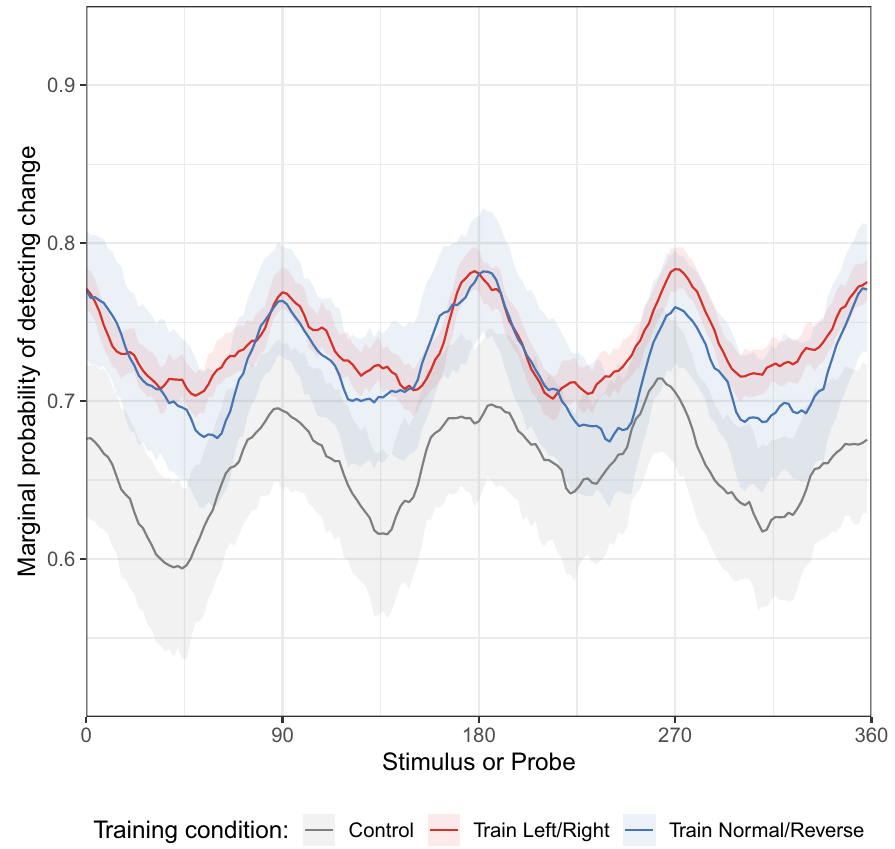
Figure 6. Mean probability of detecting a change, for a given memory stimulus or probe rake angle. Shaded regions around the lines indicate the 95% HDCI. (Figure generated using R version